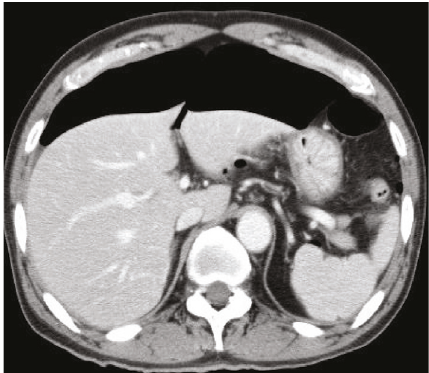
Figure 7: Emergent CT shows massive free air when the patient complained of severe abdominal